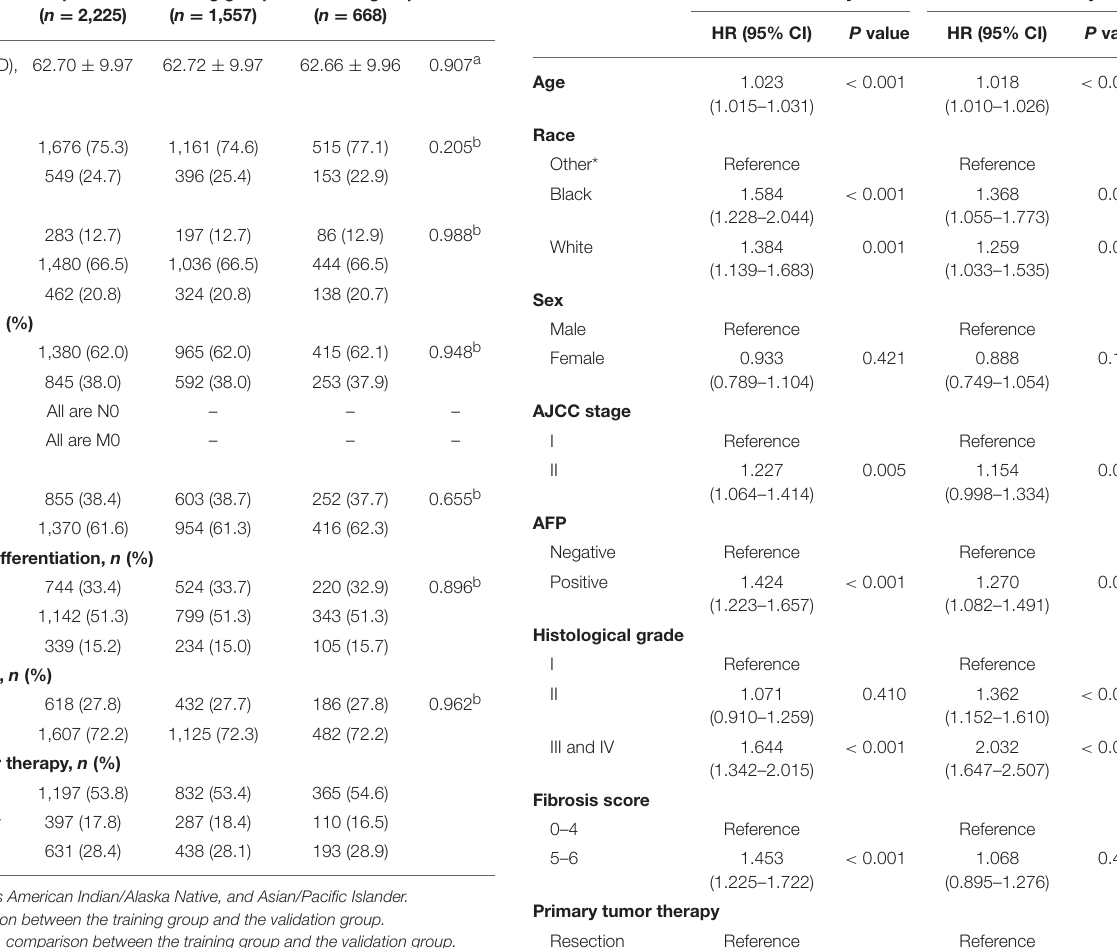
TABLE 1 | Demographics and clinical characteristics of eligible patients with early HCC. All patients ( n = 2,225)